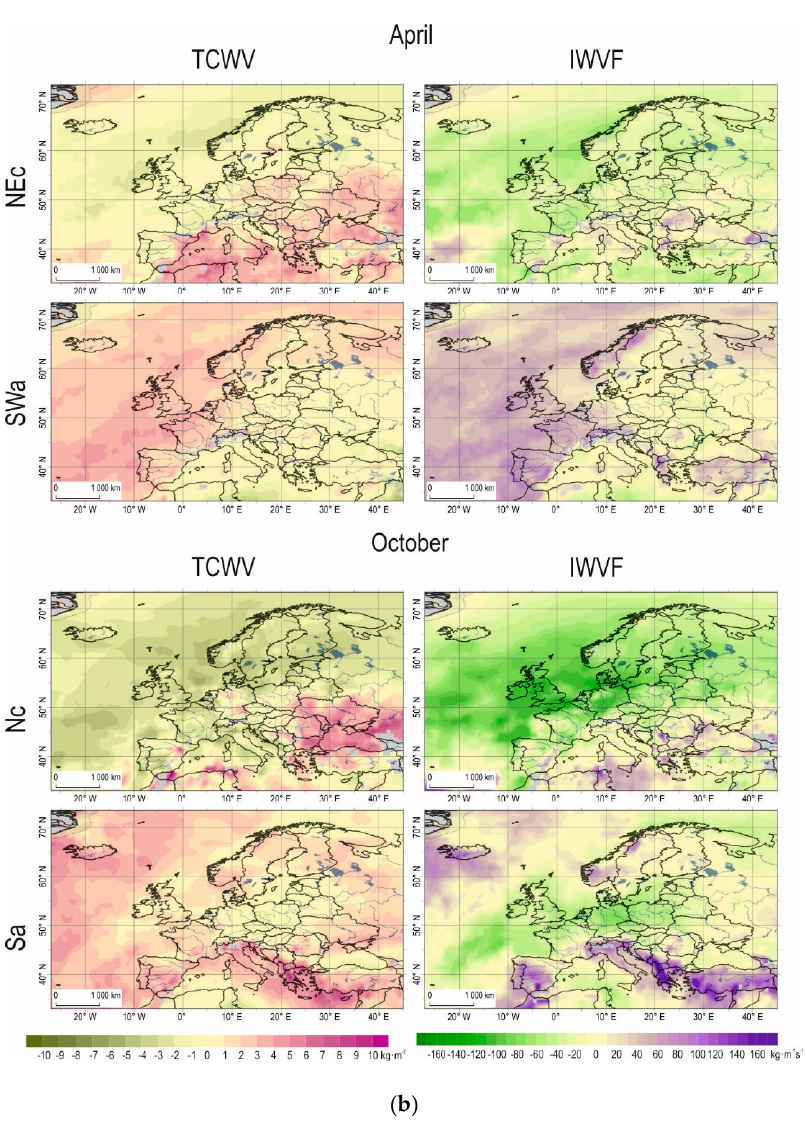
Figure 9. Anomalies of total column water vapor (TCWV) and total column water vapor flux (IWVF) for selected advection types in ( a ) January and July (1981–2015), ( b ) April and October (1981–2015). Grey shadows indicate absence of advection type occurrence.